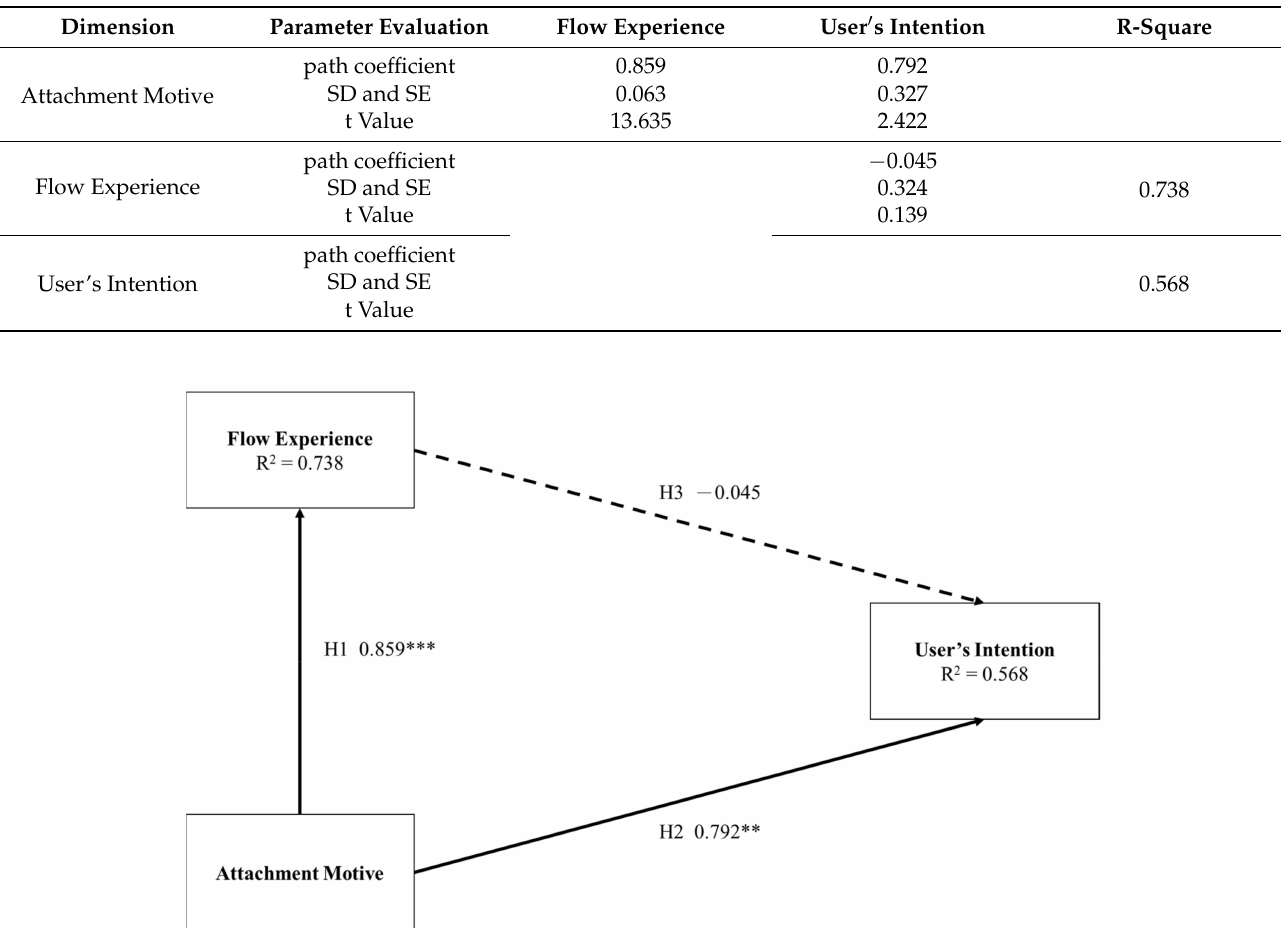
Table 3. Results of path analysis.